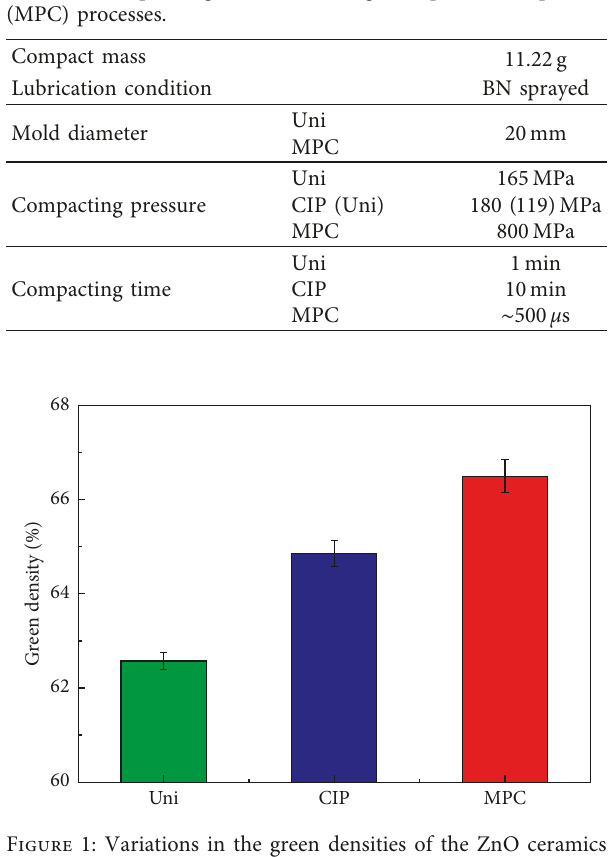
Figure 1: Variations in the green densities of the ZnO ceramics prepared using the three compacting methods (uniaxial pressing, CIP, and MPC) with respect to the sintering temperature and